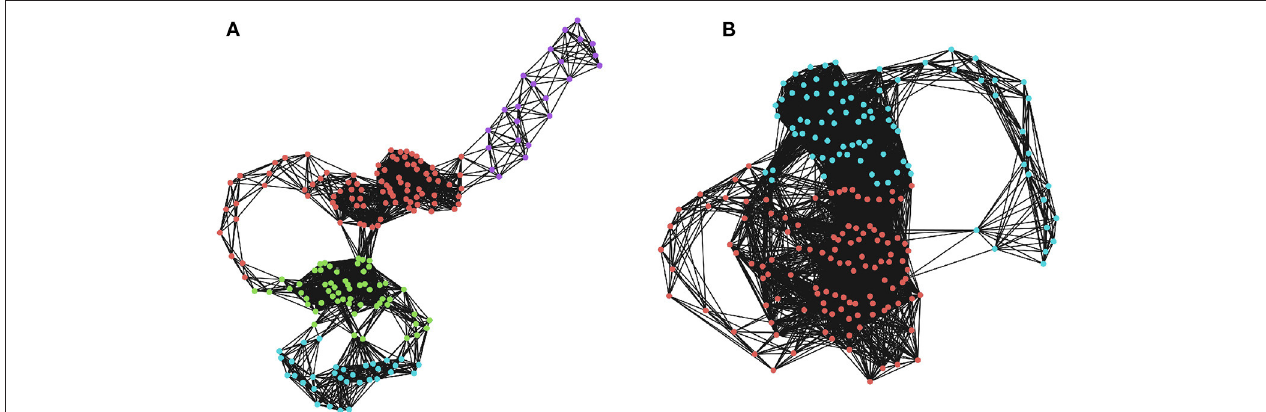
FIGURE 2 | Community detection in recurrence networks. The effects of ǫ on the higher-order community structure of the RNs. Communities were determined using a greedy modularity maximization function in networkX (Hagberg et al., 2008). (A) The community structure when ǫ is 20% of the maximum distance. Here, there are four distinct communities corresponding to temporally distinct “regions” of the phase space that the system visits in sequence. (B) The community structure when ǫ is 30% of the maximum distance, which only returns two communities that are not as restricted in time. Depending on the threshold, two moments can be lumped into the same, or different